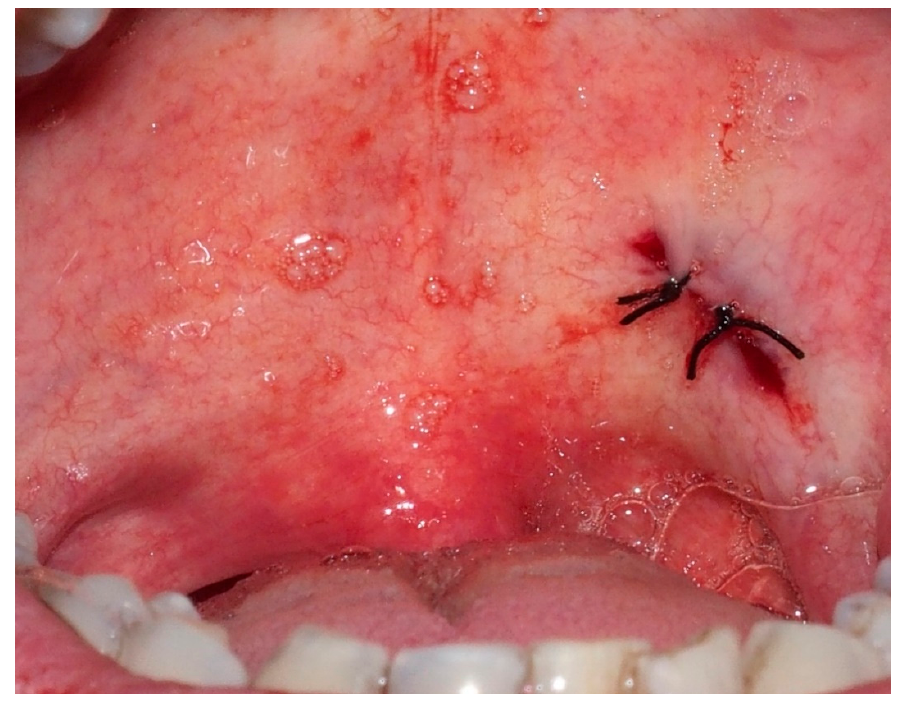
Figure 2. Soft palate after excision of the lesion.